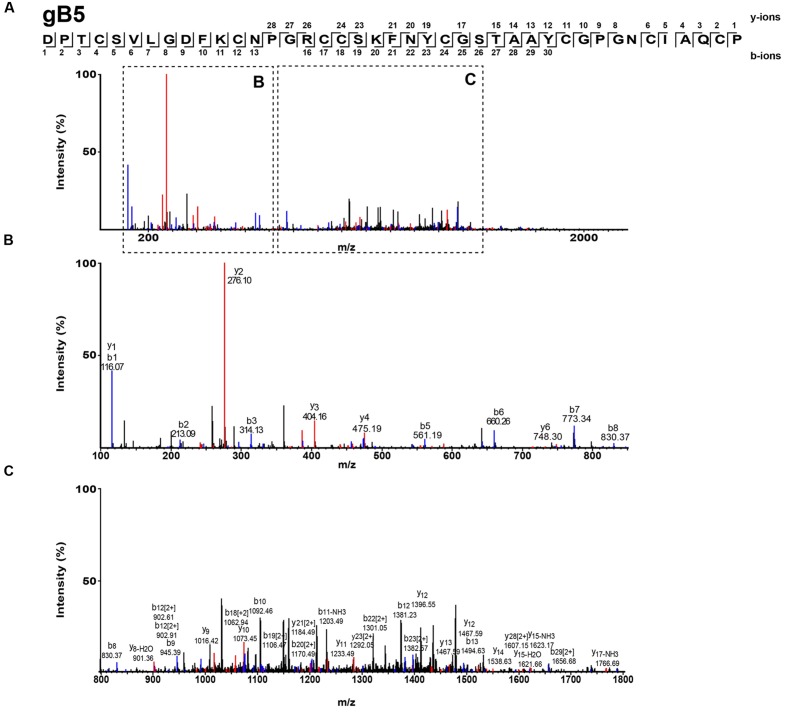
Mass spectra of ginkgotides gB5 from LC-ESI-LTQ-Orbitrap MS/MS in positive ion mode. The purified gB5 was S-reduced by 20 mM dithiothreitol, S-alkylated with 200 mM iodoacetic acid and subsequently de-salted by C18 Ziptip. The spectrum was scanned between mass ranges of (A) 100 and 2000 m/z, (B) 100 and 900 m/z, and (C) 800 and 1800 m/z. Assignment of isobaric amino acids such as Leu/Ile were confirmed by the transcriptome.